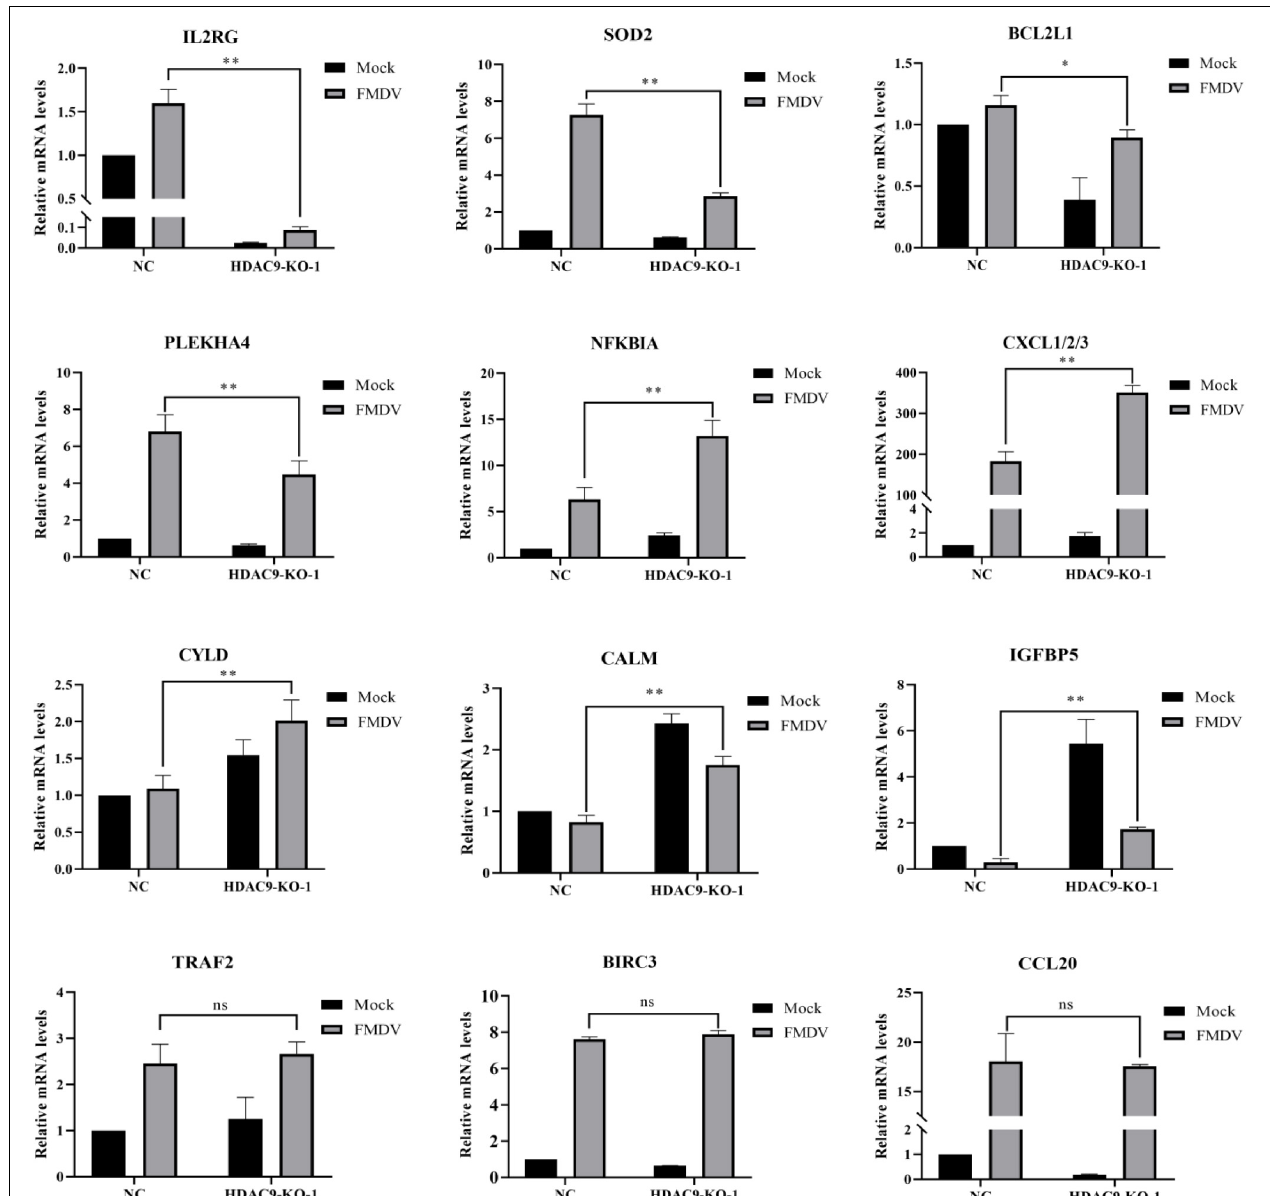
FIGURE 7 | Verification of RNA-seq data with RT-qPCR. Validation of the differentially expressed genes using the RT-qPCR assay in NC and HDAC9-KO-1 cells. Experiments were performed in triplicate and repeated three times with similar results. Data are presented as mean ± SD ( n = 3). Statistical significance was analyzed by Student’s t -test: * p < 0.05, ** p <